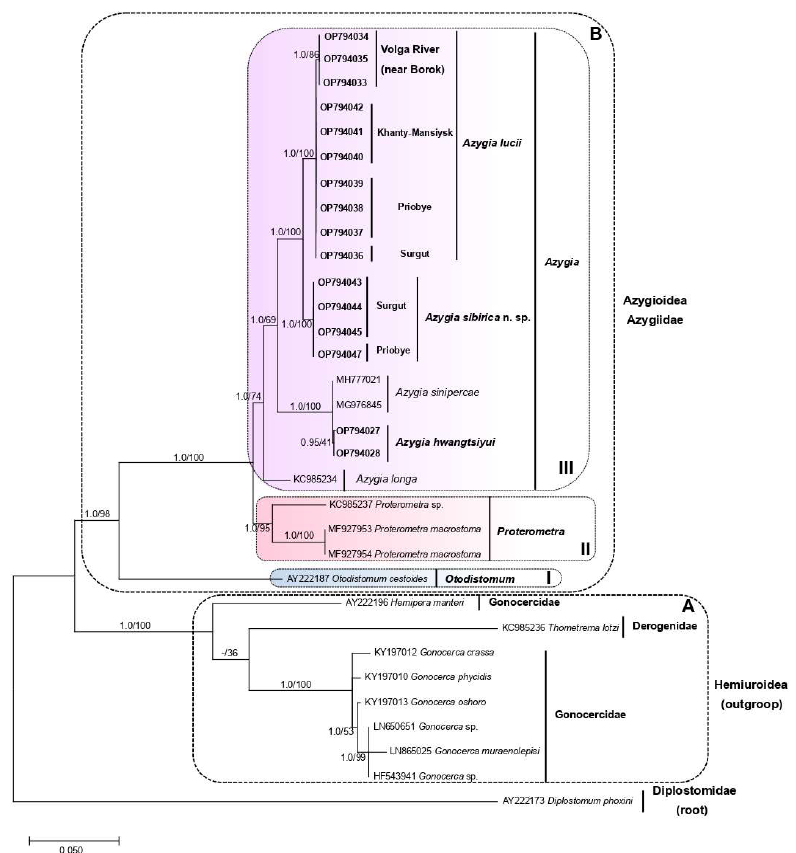
Figure 4. The consensus phylogenetic tree (BI/ML), reconstructed for eight azygiid species (analyzed group) and six hemiuroid species (outgroup), based on the 28S rRNA gene fragment. The values of the bootstrap support are indicated on the branches. The tree was rooted with Diplostomum phoxini . Symbols on the figure: A, B – clades; I, II,III – subclades.